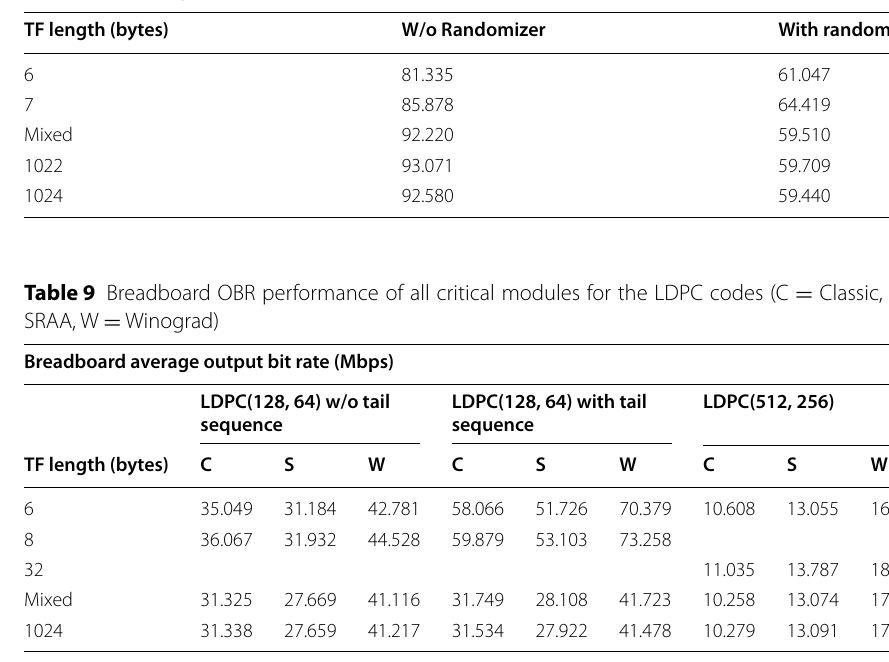
Table 8 Breadboard OBR performance of all critical modules for the BCH(63,56) code Breadboard average output bit rate [Mbps]